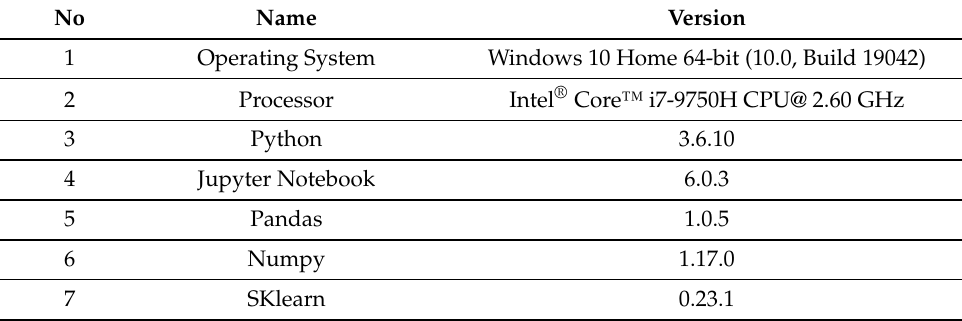
Table 2. Information of our experimental